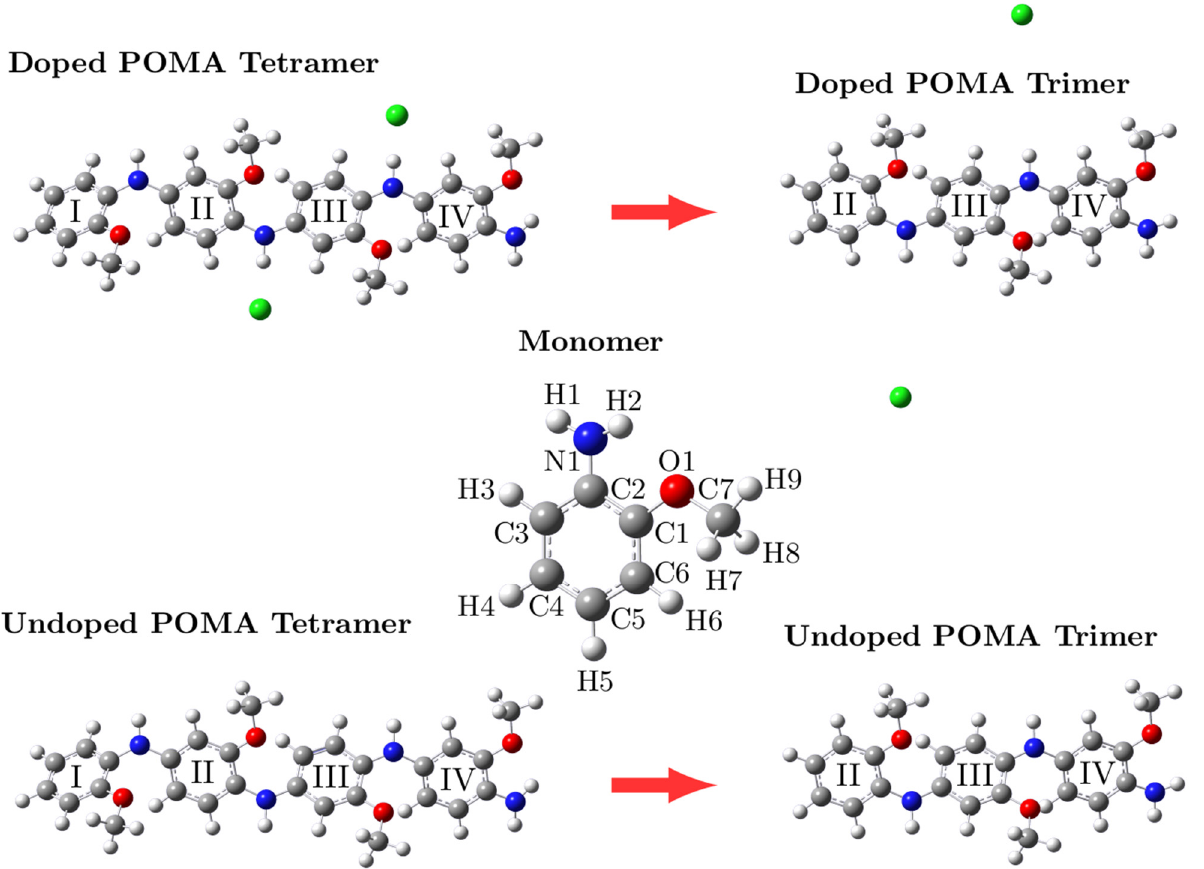
Figure 8. Geometric optimization of doped-POMA (ES-POMA) tetramer, undoped-POMA tetramer, doped-POMA (ES-POMA) trimer, and undoped-POMA trimer. Table 2. Bond length of doped-POMA (ES-POMA) tetramer, undoped-POMA tetramer, doped-POMA (ES-POMA) trimer, and undoped-POMA